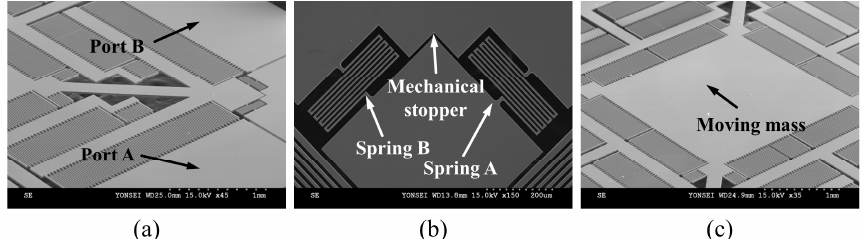
Figure 4. Scanning electron microscopy (SEM) images of the fabricated harvester. ( a ) Quadratic view showing comb-finger arrays, springs, and electrodes; ( b ) edge of the moving mass attached with spring A and B (identical design), whose excessive movement is restricted by a mechanical stopper; ( c ) wide view showing the moving mass and comb-finger